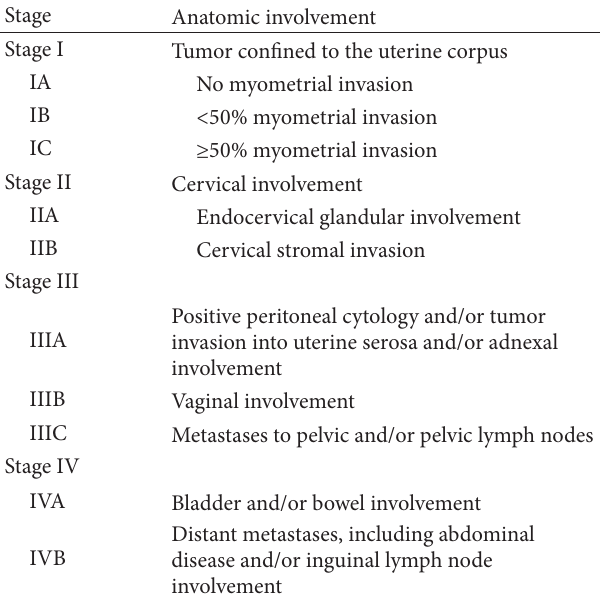
Table 1: 1998 FIGO staging system for endometrial cancer.